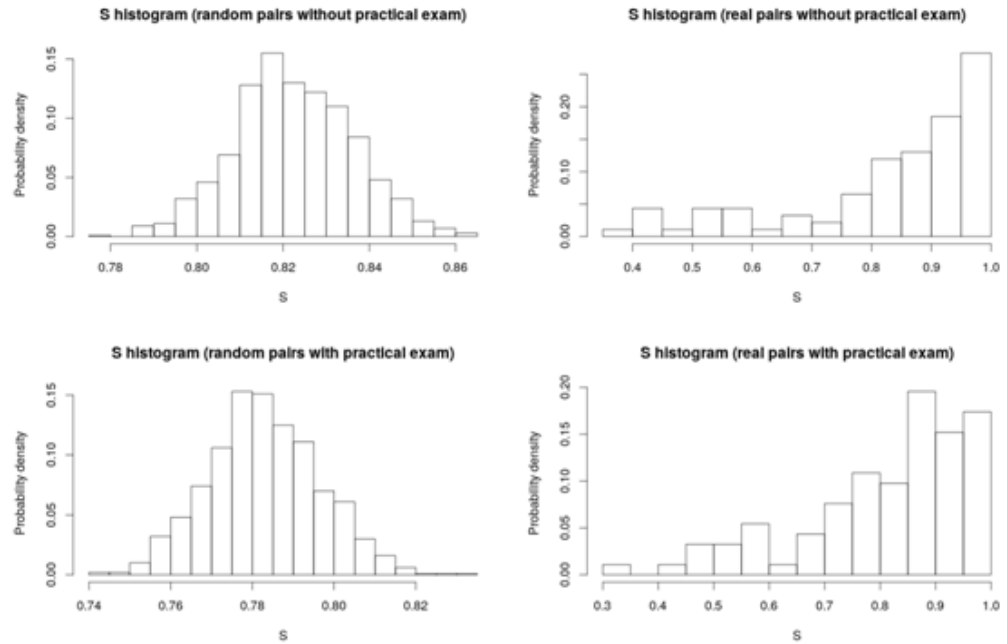
Figure 2. Histograms of S, the average similarity between the grades of the members of the couples. The latter is defined as the cosine similarity between vectors of individual grades of each student of the couple. Students come from the spring semester (2015) edition of the course Programming 2 (PRO2). The comparison consists of: random pairs excluding the scores of the practical exam (upper left panel), real pairs excluding the scores of the practical exam (upper right panel), random pairs including these scores (bottom left panel) and real pairs including these scores again (bottom right